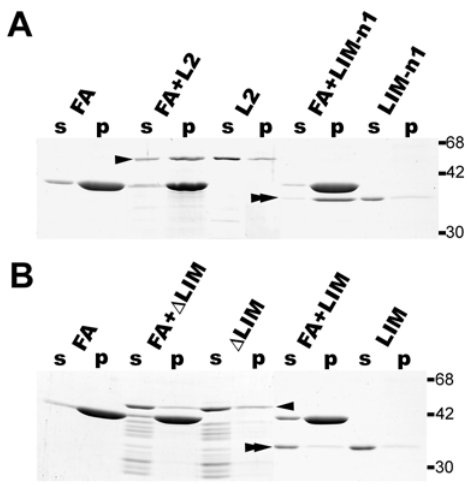
Figure 2. F-actin-binding activity of recombinant lasp-2 and its fragments in the co-sedimentation assay. 0.2 mg/ml G-actin was polymerized with GST-lasp-2 (L2), GST-LIM-n1 (LIM-n1), GST- D LIM ( D LIM), or GST-LIM (LIM). The molar ratio of GST-fused fragment to G- actin was set at 1/5. GST-lasp-2 (arrowhead in A) and GST-LIM-n1 (double-arrowhead in A) were co-precipitated with actin filaments, but GST- D LIM (arrowhead in B) and GST-LIM (double-arrowhead in B) were not. FA indicates a control experiment using F-actin without the recombinant peptides. The precipitants (p) were separated from the supernatant (s) by ultracentrifugation. The arrowheads and double- arrowheads indicate bands of recombinant GST fused proteins with the predicted molecular mass. The mobilities of molecular mass markers are listed on the right of the gel images in kilodaltons.